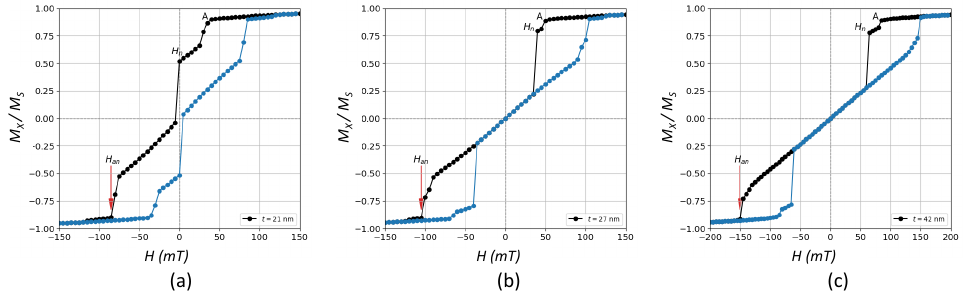
Figure 1. Zero − temperature hysteresis loops for samples with L = 300 nm and three different thicknesses, namely (a ) t = 21 nm, ( b ) t = 27 nm, and ( c ) t = 42 nm. Different colors are used to differentiate the branches corresponding to the decreasing field branch (black circles) and the increasing field branch (blue circles). Nucleation ( H n ) and annihilation ( H an ) fields are indicated. Coercive force ( H c ), only different from zero in ( a ), corresponds to the field for the magnetization passing through zero.“A” stands for a first activation field ascribed to a high mobility of domain walls before vortex nucleation.